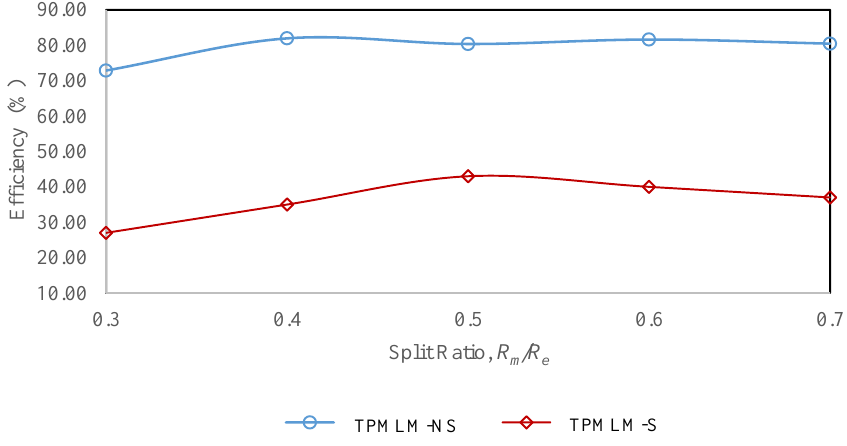
Figure 16. Influences of Split Ratio, R m /R e on Efficiency.